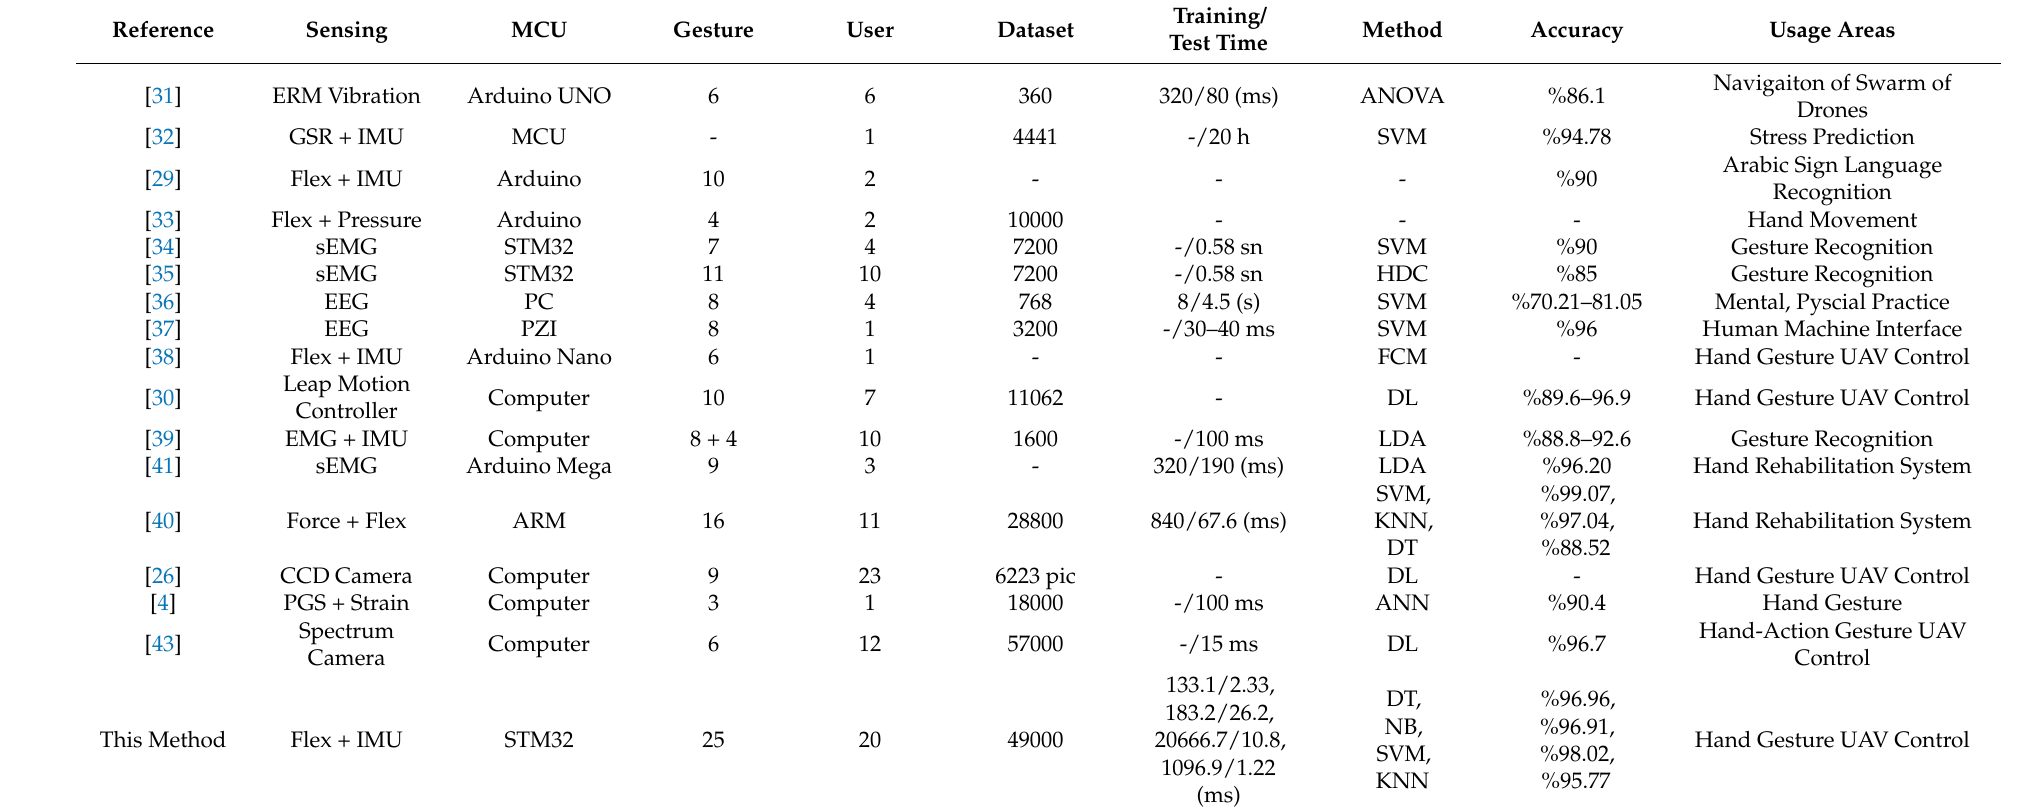
Table 8. Comparison of the proposed system with other